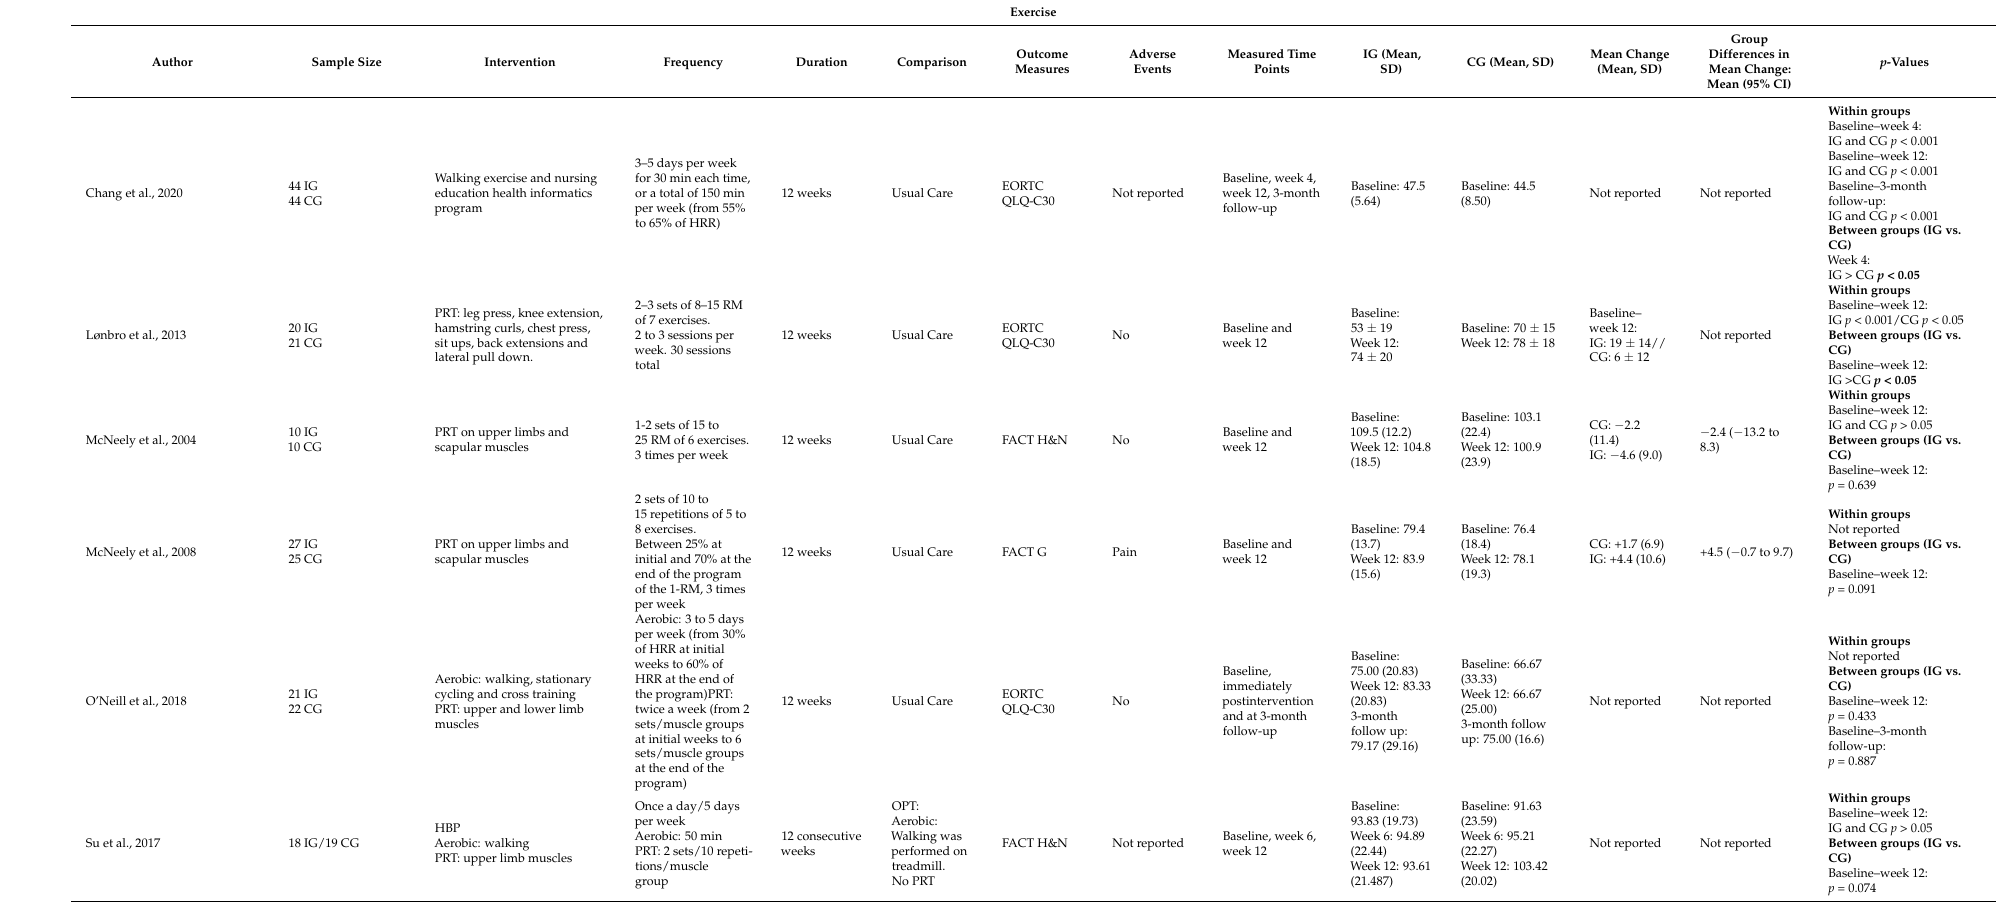
Table 2. Summary of the interventions on the included